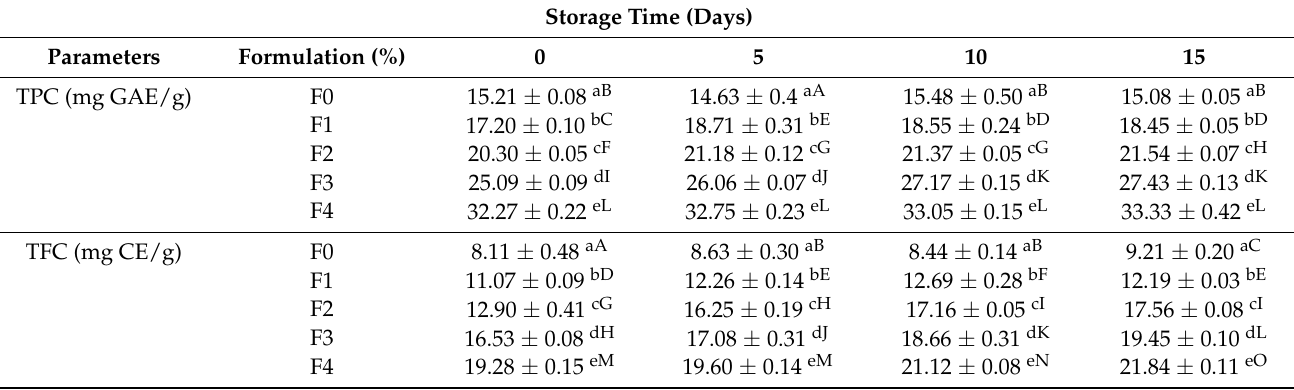
Table 2. Effects of MOLP on polyphenolic compounds (dry basis) of ground beef stored at 4 ± 1 ◦ C for 15